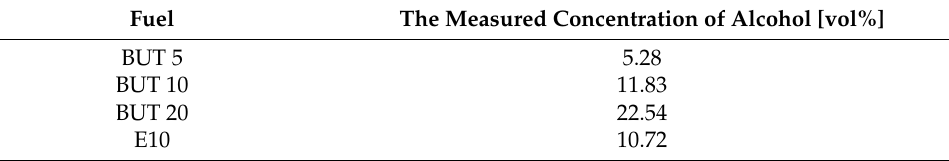
Table 7. Measured concentrations of ethanol and n-butanol in diesel fuel.